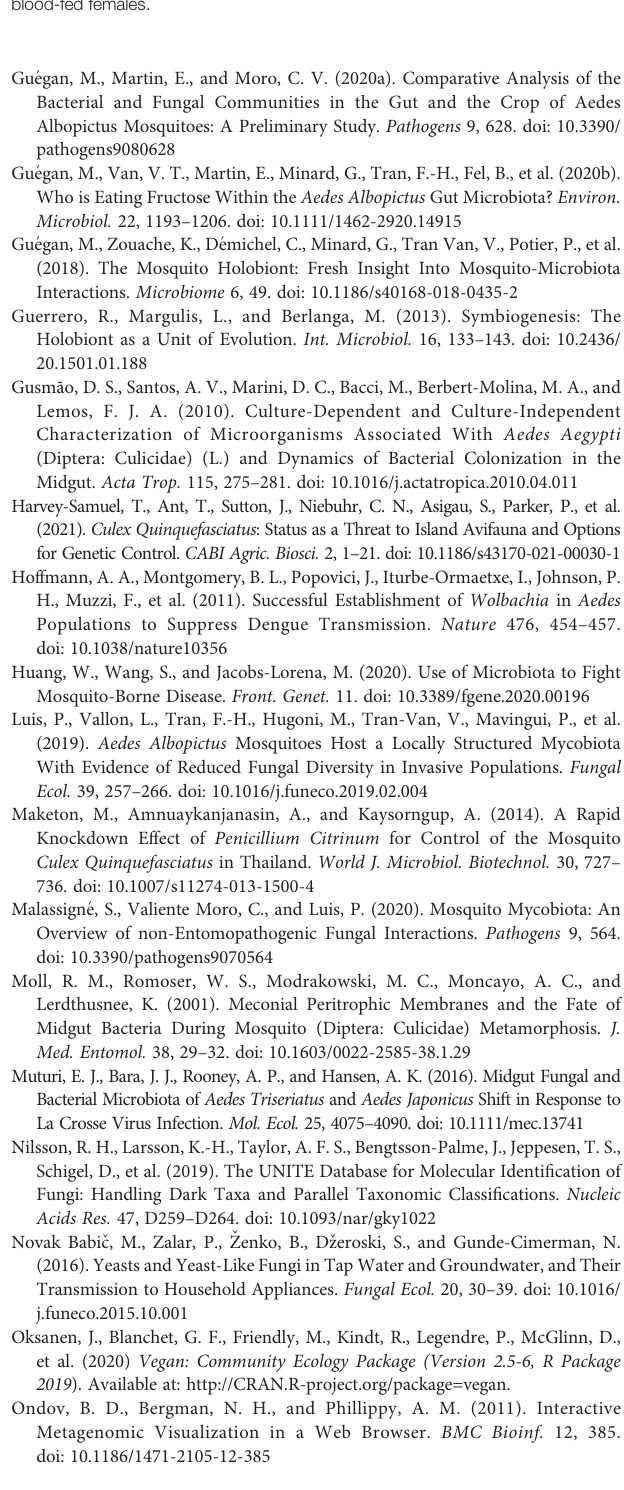
interactive zooming and multi-layered fungal map obtained by Krona (html format), showing the mean taxonomic distribution and relative abundance of taxa. Supplementary Table 2 | Reads assigned as fungal OTUs at 97% identity from all mosquito stages: L, larvae; M, sucrose-fed male; SF, sucrose-fed females; BF, blood-fed